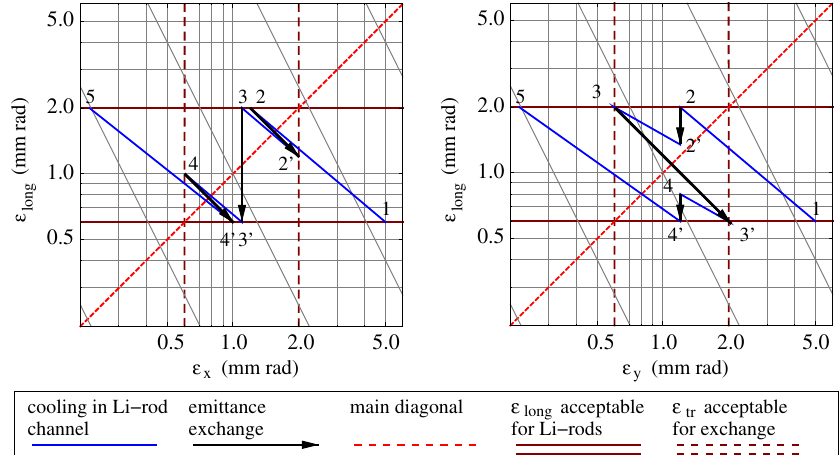
FIG. 9. Conceptual view of emittance exchange usage for Li-rod cooling scheme. The consecutive steps are as follows: beam cooling in the linear Li-rod based channel ( 1 ! 2 ), symplectic emittance exchange from horizontal ( x ) to longitudinal degree of freedom ( 2 ! 2 0 ), second Li-rod based cooling channel ( 2 0 ! 3 ), symplectic emittance exchange from vertical ( y ) to longitudinal degree of freedom ( 3 ! 3 0 ), third Li-rod based cooling channel ( 3 0 ! 4 ), symplectic emittance exchange from horizontal ( x ) to longitudinal